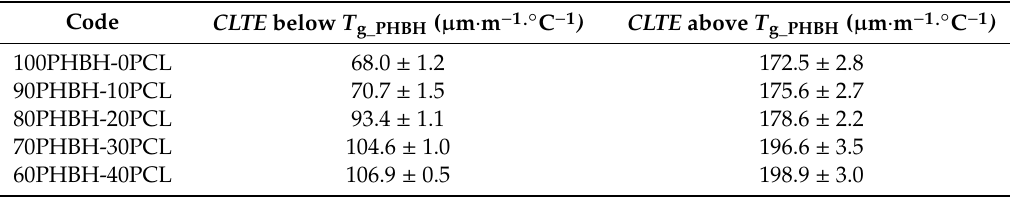
Table 4. Coe ffi cient of linear thermal expansion (CLTE) of PHBH / PCL blends with di ff erent PCL wt %, below and above T g_PHBH , obtained using thermomechanical analysis